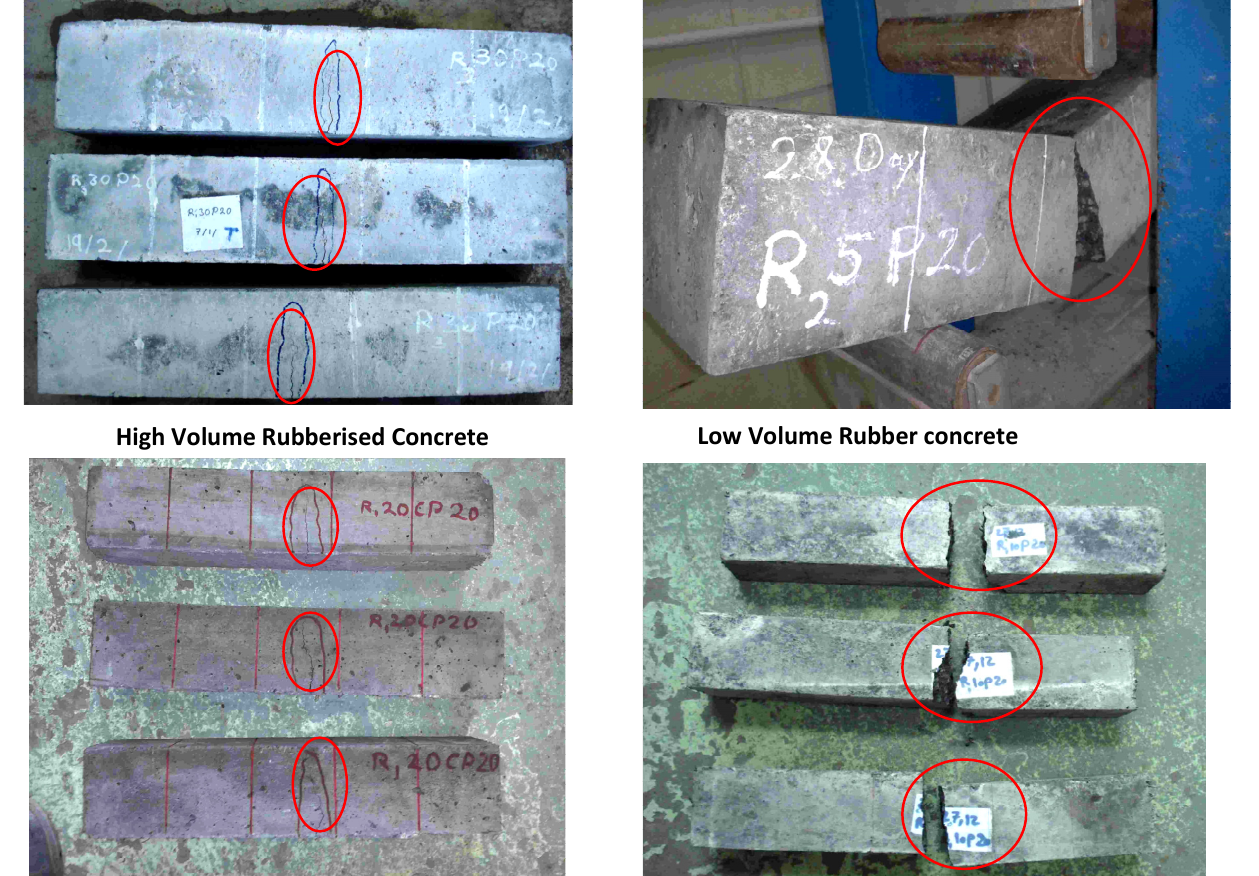
Figure 13. Failure mode of concrete under flexural test of rubberized POFA concrete containing high (20% and 30%) and low (5% and 10%) volumes of rubber aggregates.